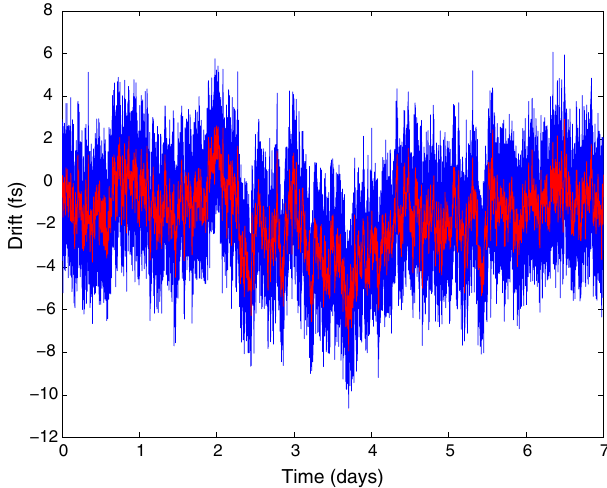
FIG. 35. Long-term drift measurement of a 500 m long CW optical link: raw data at 1 Hz (blue curve), and filtered with a time window of five minutes (red curve). See text for